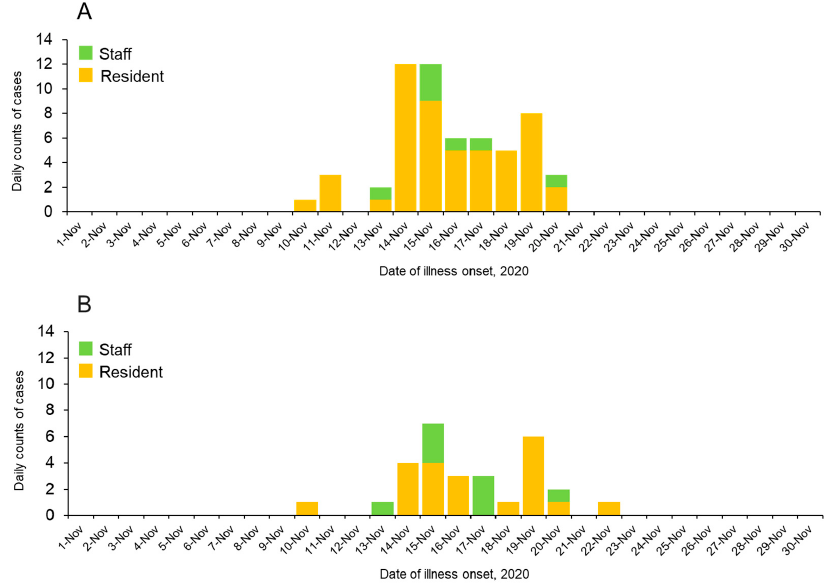
Figure 1. Epidemic histogram of SARS-CoV-2 outbreak in nursing care home in Niigata, Japan, November 2020. ( A ) Epidemic histogram of reverse transcription PCR (RT-PCR) positives at the time of the outbreak ( n = 58). ( B ) Epidemic histogram of RT-PCR positives who participated in